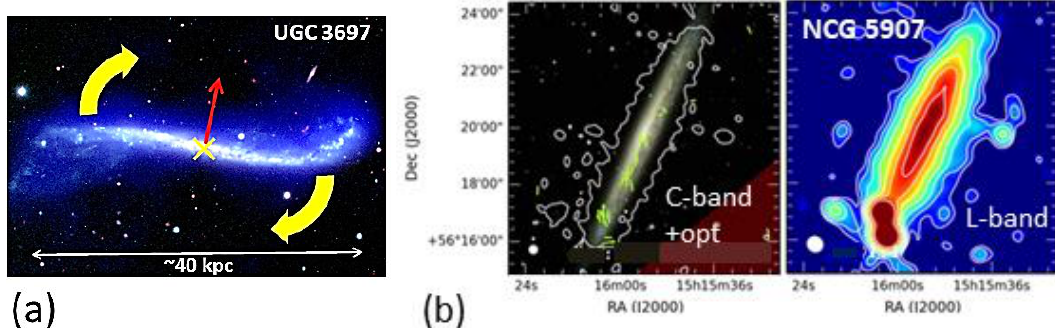
Figure 1. Distributions of baryonic matter in edge-on spiral galaxies: ( a ) Visible image of ultrathin UCC3697 (whitish). The blue overlay images the surrounding neutral H atom gas, detected using the L-band, which includes emissions at 21 cm. Thin red arrow indicates the z-axis. Yellow X indicates a secondary spin axis, pointing into the page with the sense shown by the curved yellow arrows. This secondary spin explains the form of the warp (see Section 2.2 ). Publicly available from NRAO / AUI / NSF [23]; ( b ) Radio contours of NGC5907 in the C- and L-bands, with an optical image, are publicly available at https: // www.queensu.ca / changes / . The L-band range. The CHANG-ES project [24] is described in Irwin et al. 2012, AJ, 144, 43 [25] and details about this first data release are provided by Wiegert et al. 2015, AJ, 150, 81 [26].